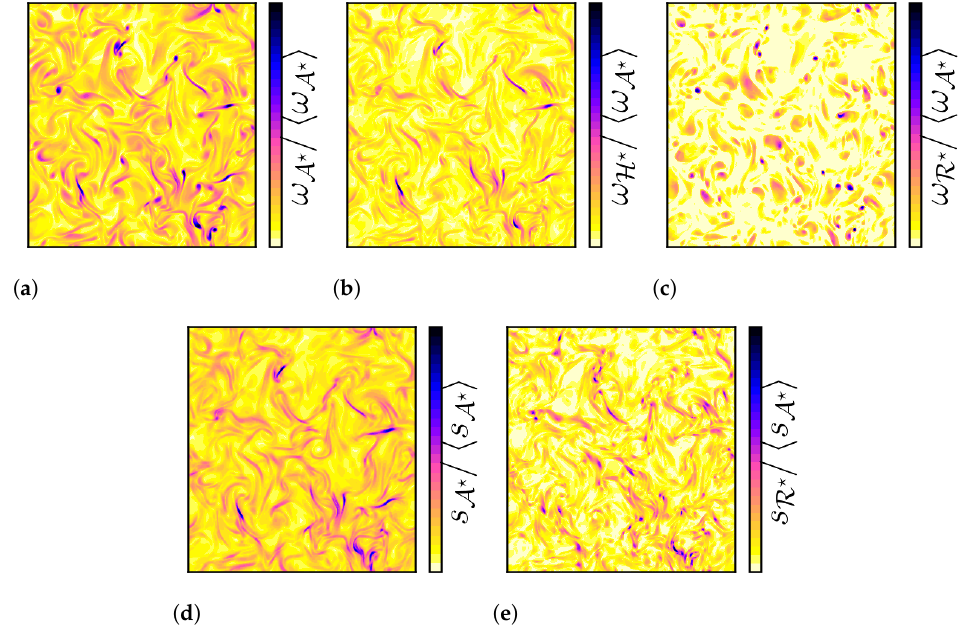
Figure 7. Color contour of the normalized ( a ) ω A (cid:63) and ( d ) s A (cid:63) and their components ( b ) ω H (cid:63) , ( c ) ω R (cid:63) , and ( e ) s N (cid:63) on the x 1 - x 2 plane for Ma t =